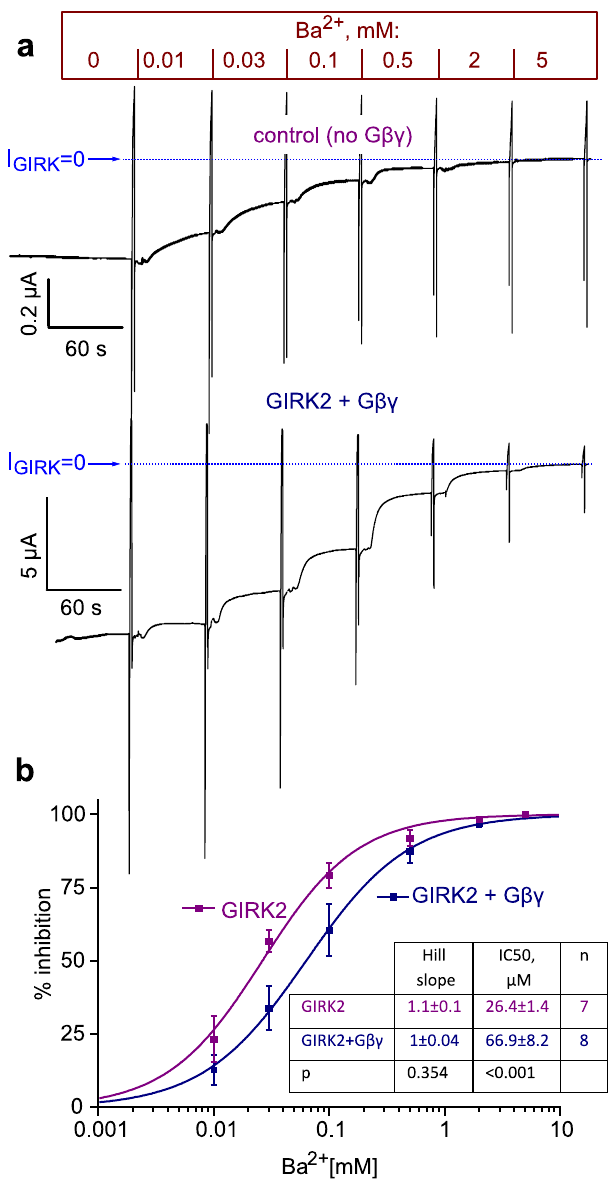
Fig. 8 Ba 2 + block is altered following activation of hGIRK2 wt by G βγ . a Representative records of Ba2 + dose – response experiments in oocytes expressing hGIRK2 wt (upper trace) or hGIRK2 wt + G βγ (lower trace). The currents were measured at − 80mV. A voltage ramps was applied toward the end of each episode with the indicated Ba 2 + concentration, and after that the solution was switched to the next, higher Ba 2 + concentration. b Summary of the experiment. Averaged normalized data (% of current inhibition) are shown as mean±SEM. These averaged dose – response relationships were fi tted to the Hill equation (Eq. (9), see the “ Methods ” section) with the following parameters: hGIRK2, h (Hill slope) = 1.053, IC 50 = 26 µ M; hGIRK2 + G βγ , h = 0.98, IC 50 = 63 µ M. In addition, in each oocyte, the dose- response relationship was fi tted separately to the Hill equation. Average parameters ( h and IC 50 ) are shown in the table (inset). Statistical analysis was done using t -test (Hill slope) and Mann – Whitney test (IC 50